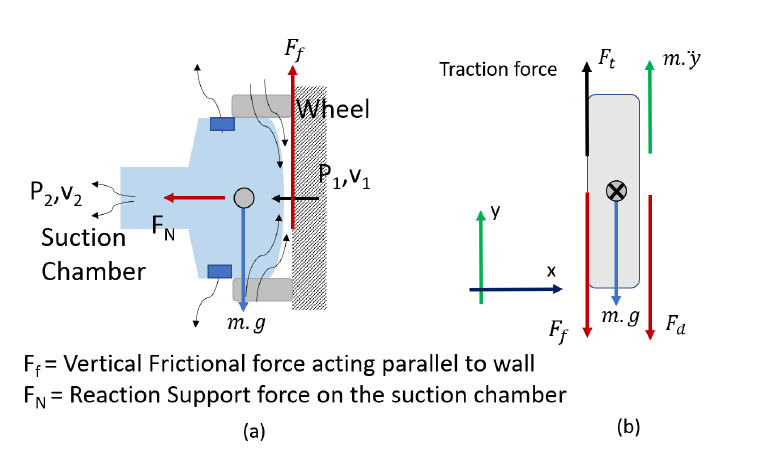
Figure 11. ( a ) Free body diagram of each suction module, ( b ) Free body diagram of the platform during